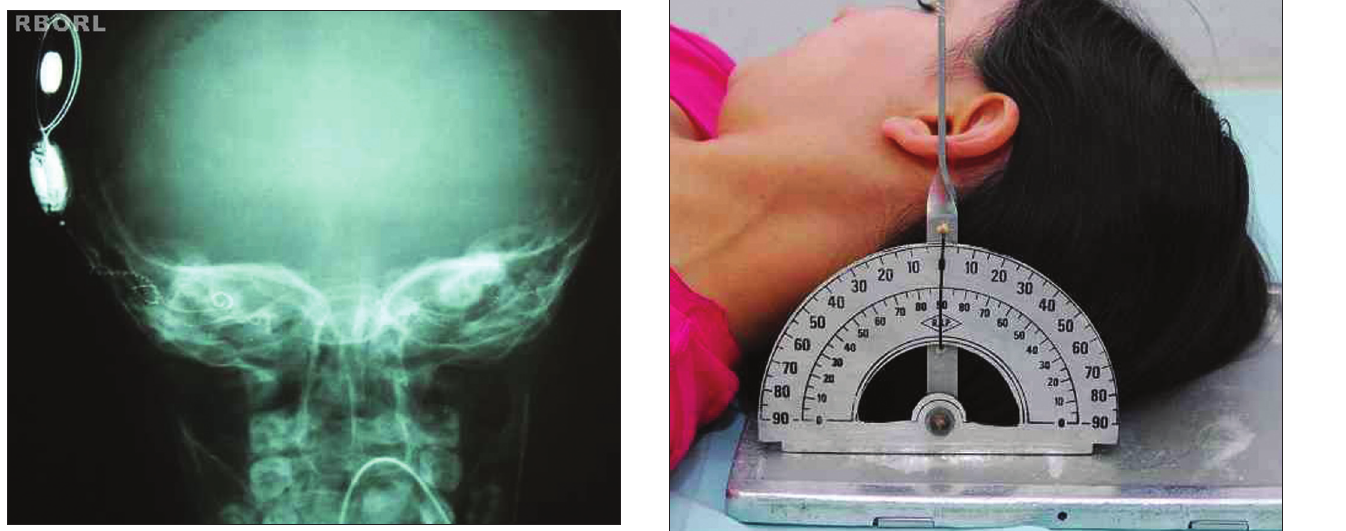
Figura 6. Posicionamento - linha órbito-meatal perpendicular ao filme: Oblíqua lateral (vista lateral).